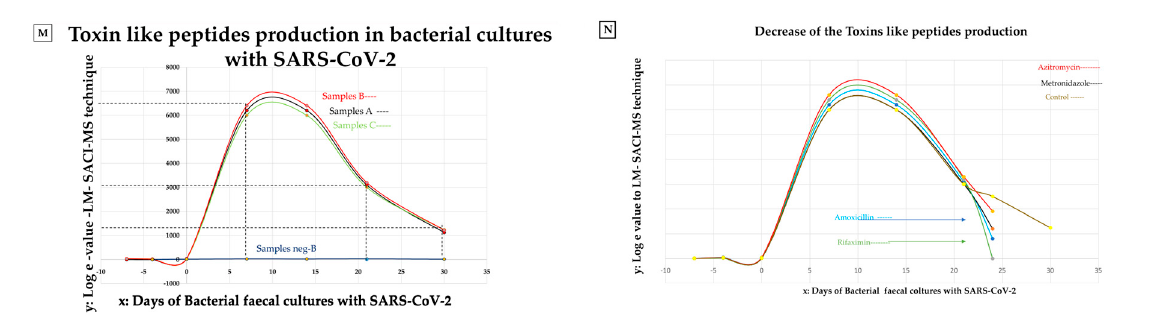
Figure 1. Toxin-like peptides data analysis. Panel ( A – F ): most commonly found toxin-like peptides (P). Panels ( G – I , L , M ) the increase of toxin-like peptides over time and the use of antibiotics. (Panels A–F ): charge ratio mass spectra of the toxins-like peptides produced in faecal bacterial culture with SARS-CoV-2. Uniprot annotation ID. (Panel A ): P0DPT2, alfa conotoxin-like peptides; (Panel B ): Q698K8, zinc metalloproteinase/disintegrin; (Panel C ): Q9PW56, Bradykinin- potentiating and C-type natriuretic peptides; (Panel D ): Q58L90, venom prothrombin activator omicarin-C; (Panel E ): basic phospholipase A2 BFBA; (Panel F ): Q9W7J9, short neurotoxin 4. (Panels G – I , L ): Spectral counting toxin-like peptides value to LC-SACI-CIMS technique. The values of the experimental repetitions at 7, 14, 21, and 30 days are represented by the box plots. The value of toxicological production in samples C (Panel I ) is similar to those in samples A (Panel G ) and B (Panel H ), also in the absence of viral SARS-CoV-2 load. (Panel L ): The amoxicillin and rifaximin stop the toxicological production versus other antibiotics in the bacterial cultures with SARS-CoV-2. (Panel M ): High Log e value, LC-SACI-CIMS ion mobility technique, of toxin-like peptides (P) presence in samples A, B, and C and low Log e value of toxins in neg-B samples. (Panel N ): Introducing four types of different antibiotics, there is a decrease in toxins production, more evidence for rifaximin and